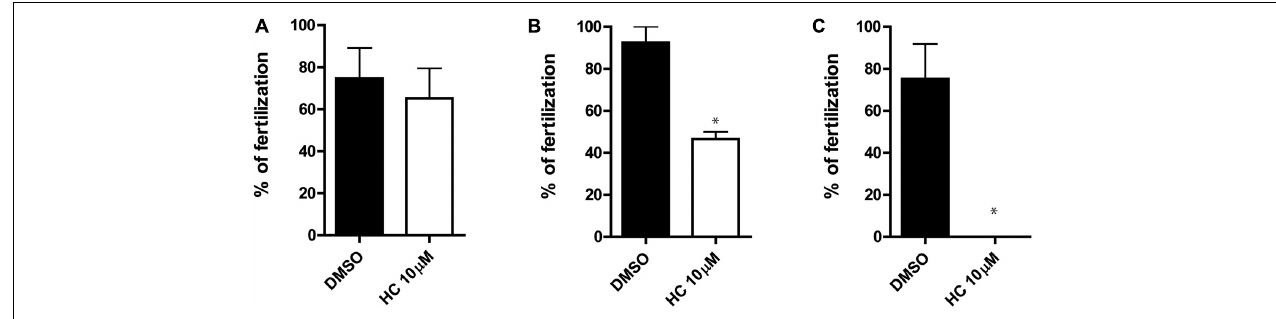
FIGURE 5 | In vivo fertilizing ability of sperm exposed to HC before intrauterine insemination. (A–C) Cauda epididymal sperm in a non-capacitating concentration (1–10 × 10 7 sperm/ml) were incubated in a medium containing 10 µ M HC for 0 min (A) , 30 min (B) , and 60 min (C) and then inseminated in the uterus of superovulated females. After 15 h, eggs were recovered from the ampulla and the percentage of fertilized eggs was determined. Eggs were considered fertilized when at least one decondensing sperm nucleus or two pronuclei were observed in the egg cytoplasm and the percentage of fertilized eggs was determined. Data are mean ± SEM of at least n = 3 independent experiments; * p < 0.05 vs.